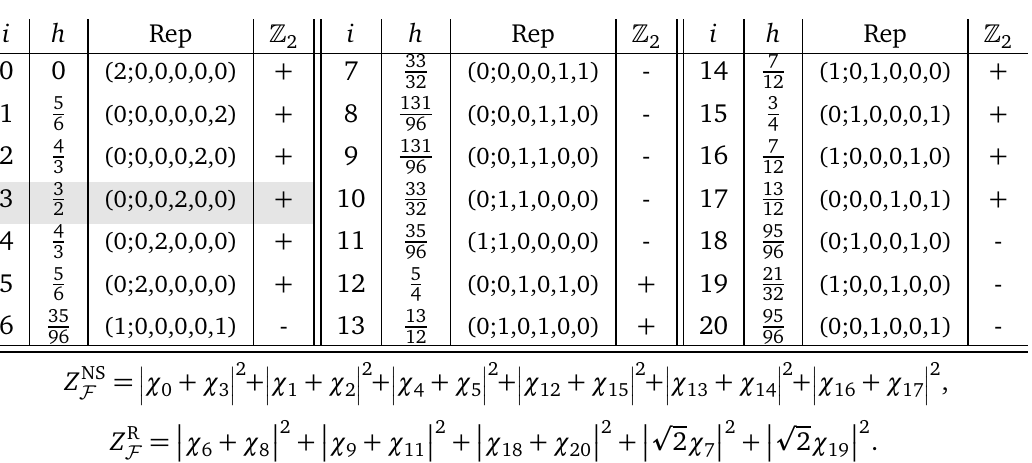
Table 9: SU ( 6 ) : primaries labeled by i are characterized by weights h and SU ( 6 ) Dynkin labels. 2 ( τ ) . We highlight the primary related to the (cid:90) Their characters are denoted by χ i center symmetry (cid:90) . The partition functions for F in the NS and R sectors are also presented. 6